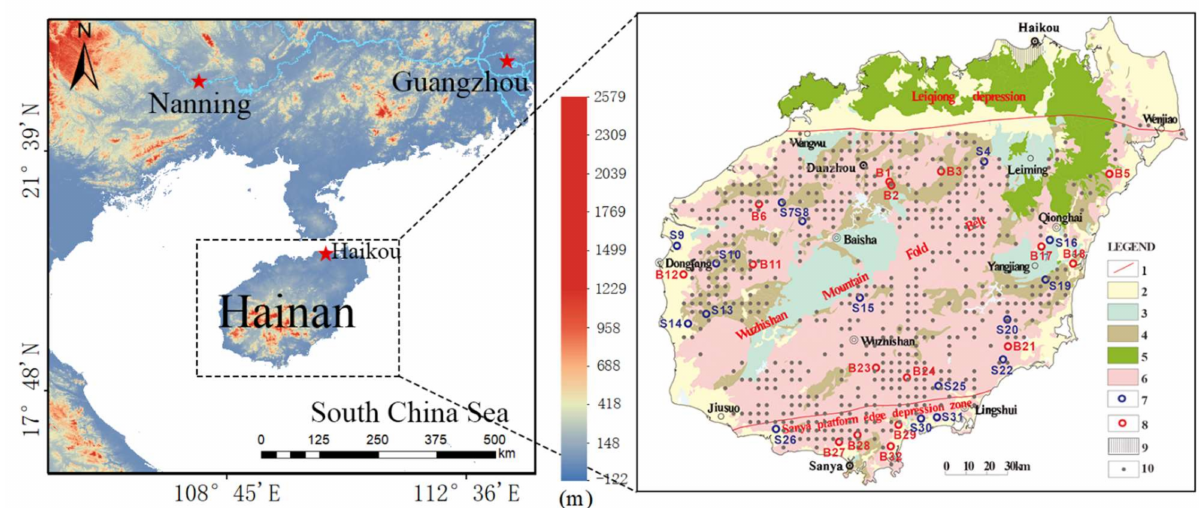
Figure 1. Geographical location of Hainan Island and distribution of lower soil samples used for prediction of thermal mineral water sites, along with known sites. 1: Geotectonic boundary; 2: Qua- ternary sediments; 3: Cretaceous sedimentary rocks; 4: Mesoproterozoic–Paleozoic sedimentary– metamorphic rocks; 5: Cenozoic basic volcanic rocks; 6: Paleozoic–Mesozoic intermediate-acid intrusive rocks; 7: known thermal mineral water sites (S: natural spring); 8: known thermal mineral water sites (B: borehole); 9: bedded thermal mineral water in northern Hainan Island; 10: distribution of lower soil samples used for